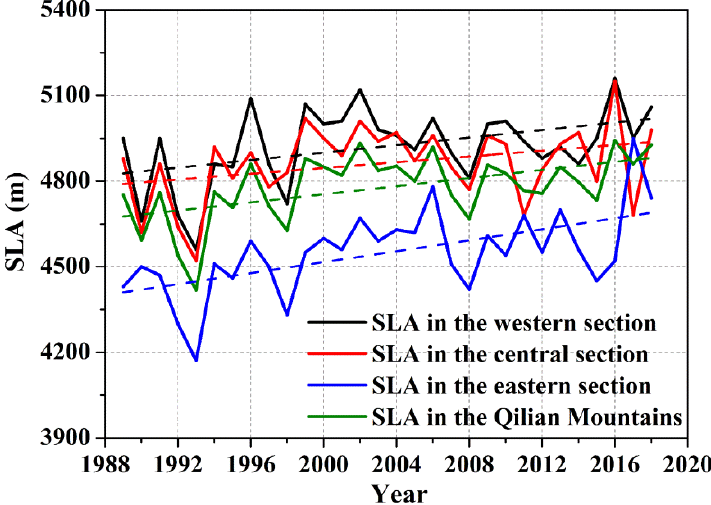
Figure 7. Glacier SLA in the western section, central section, eastern section of the Qilian Moun- tains and the Qilian Mountains during the 1989–2018 period. Dashline represent the linear fit line of the